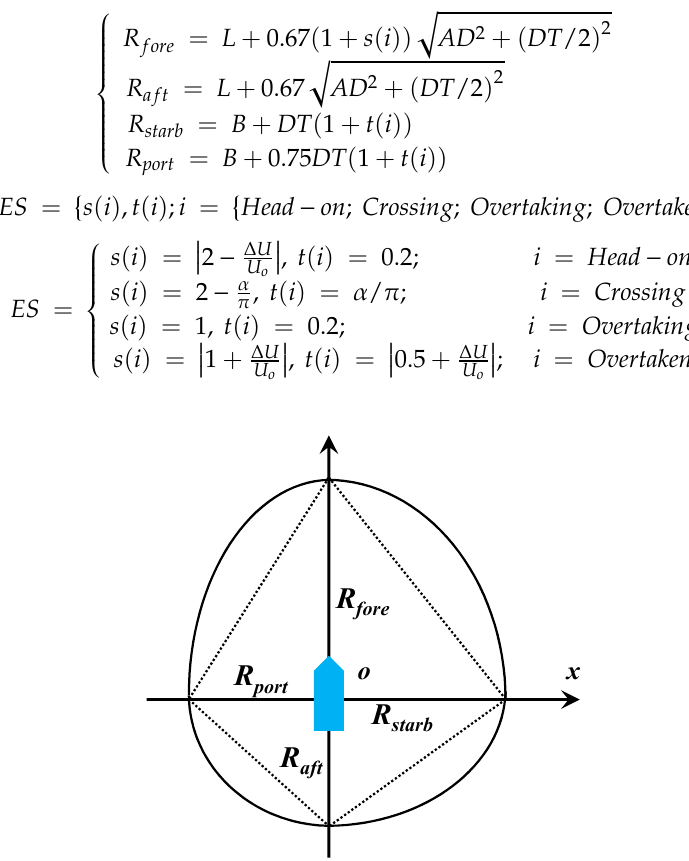
Figure 2. Basic navigation safety domain.